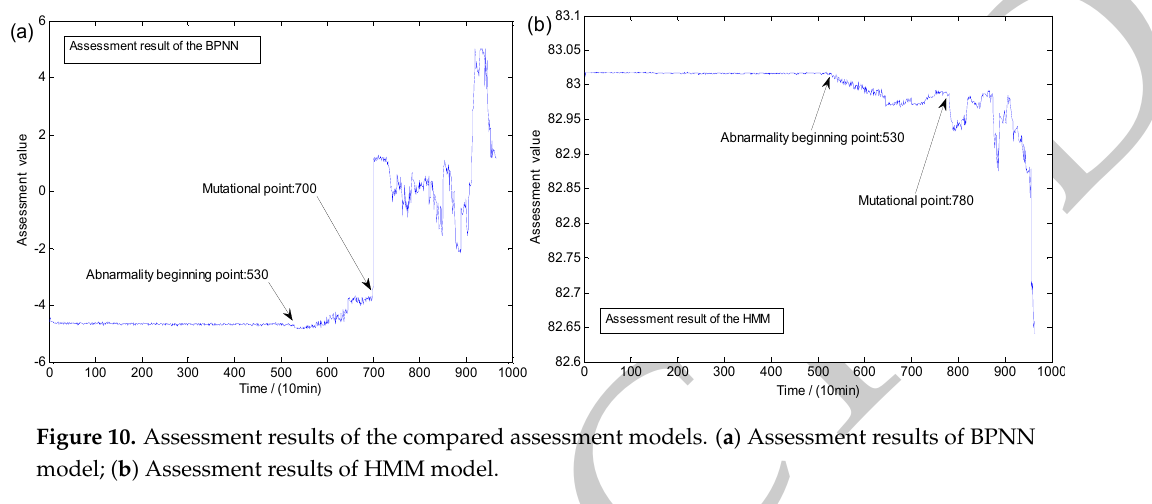
Figure 10. Assessment results of the compared assessment models. ( a ) Assessment results of BPNN model; ( b ) Assessment results of HMM model.